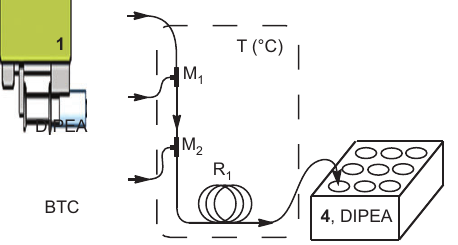
Figure 4 Schematic view of fed-batch system used for the two steps sequence